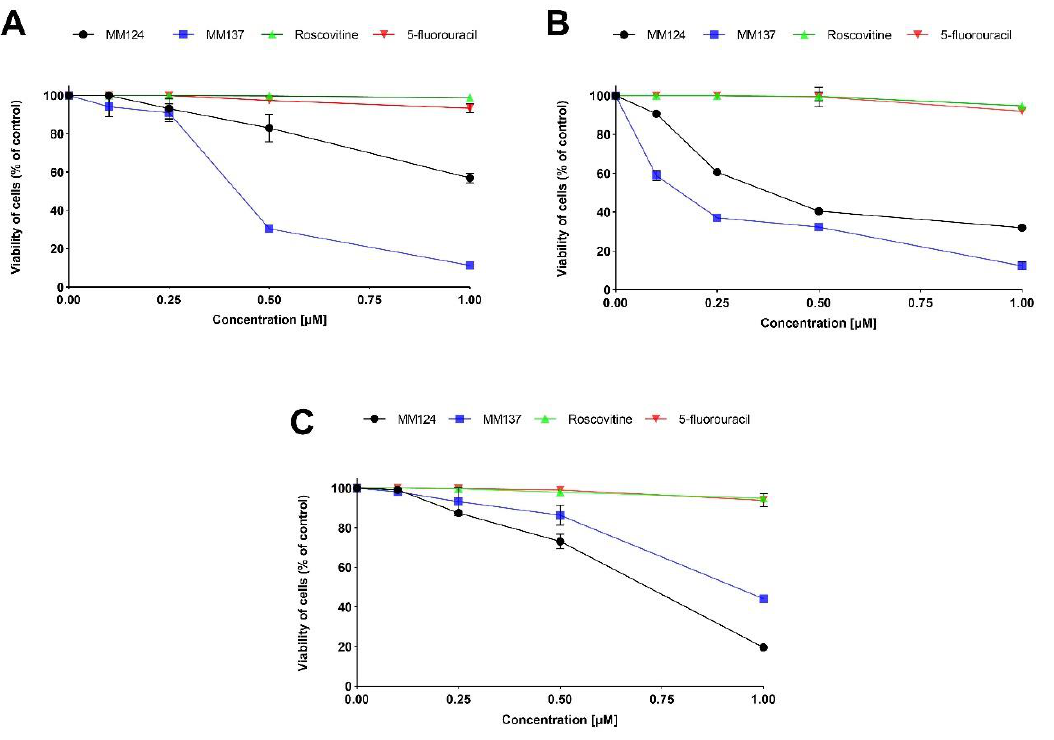
Figure 1. Viability of DLD-1 ( A ), HT-29 ( B ) human colorectal adenocarcinoma cell lines, and human skin fibroblasts ( C ) incubated for 24 h with novel 7-methyl-5-phenyl-pyrazolo[4,3- e ]-tetrazolo[4,5- b ][1,2,4]triazine sulfonamide derivatives (MM124, MM137), 5-fluorouracil, and roscovitine. Mean ± SD from three independent experiments done in duplicate are presented.